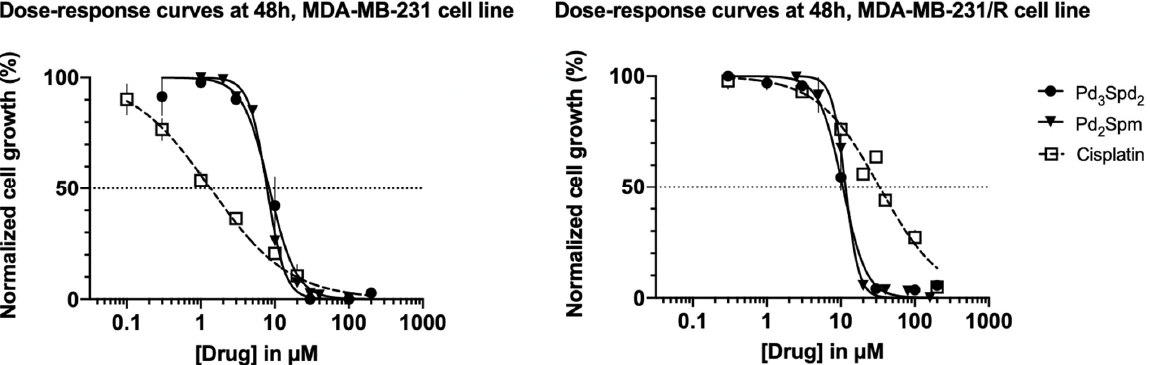
Figure 5. Impact of increasing concentrations of Pd 3 Spd 2 , cisplatin or Pd 2 Spm on TNBC sensitive and resistant to cisplatin incubated for 48 h. Dose–response curves in breast cancer MDA-MB-231 cells (sensitive to cisplatin, left panel line) and MDA-MB-231/R cells (resistant to cisplatin, right panel) at 48 h of incubation. Values are expressed as the mean ± SEM from 4 independent experi- ments (in triplicate) analyzed with nonlinear regression and the Student’s t -test. Data points with no visible error bars have errors smaller than the size of the symbol.